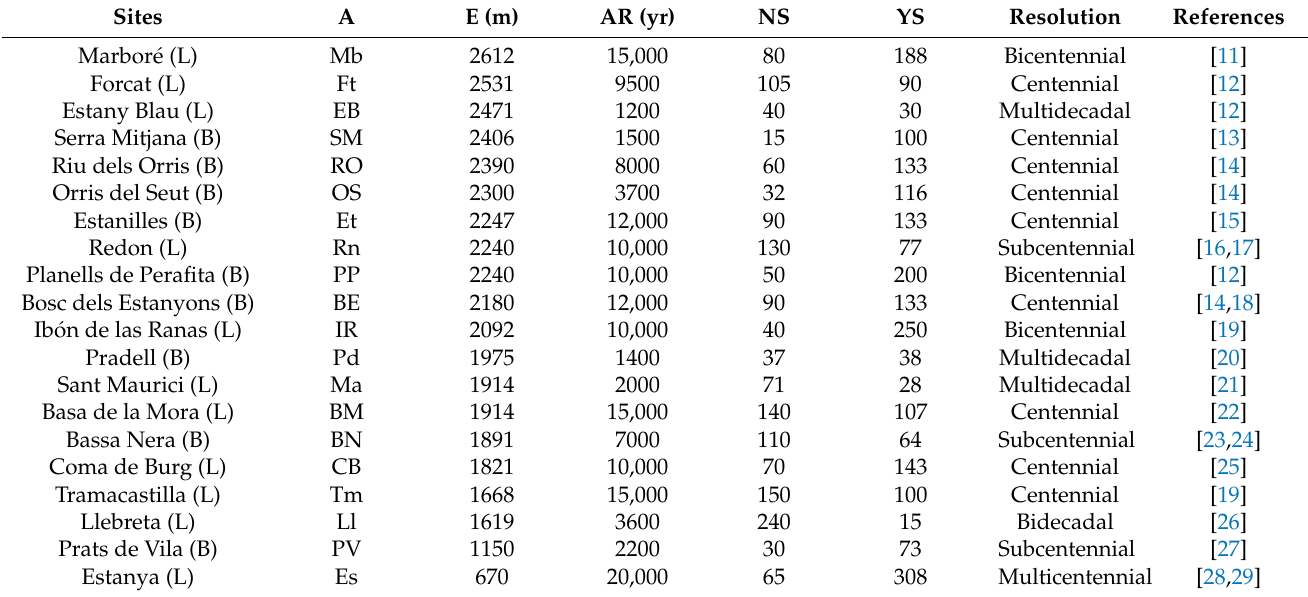
Table 1. Temporal resolution of the available vegetation reconstructions using pollen analysis in the central Iberian Pyrenees (Figure 1). L, lake; B, peat bog; A, abbreviations; E, elevation; AR, age range; NS, number of samples; YS, years per sampling